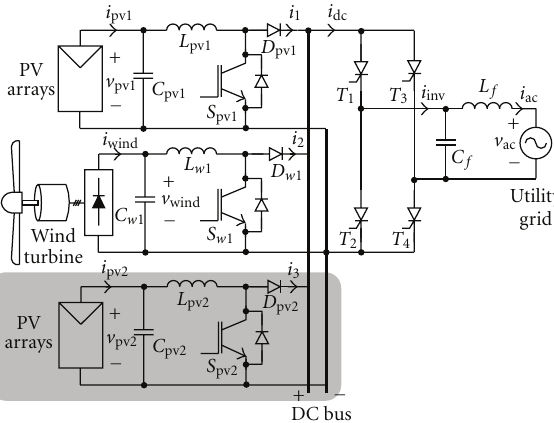
Figure 18: Extension energy sources for increasing the output power of the proposed hybrid PV/wind system.